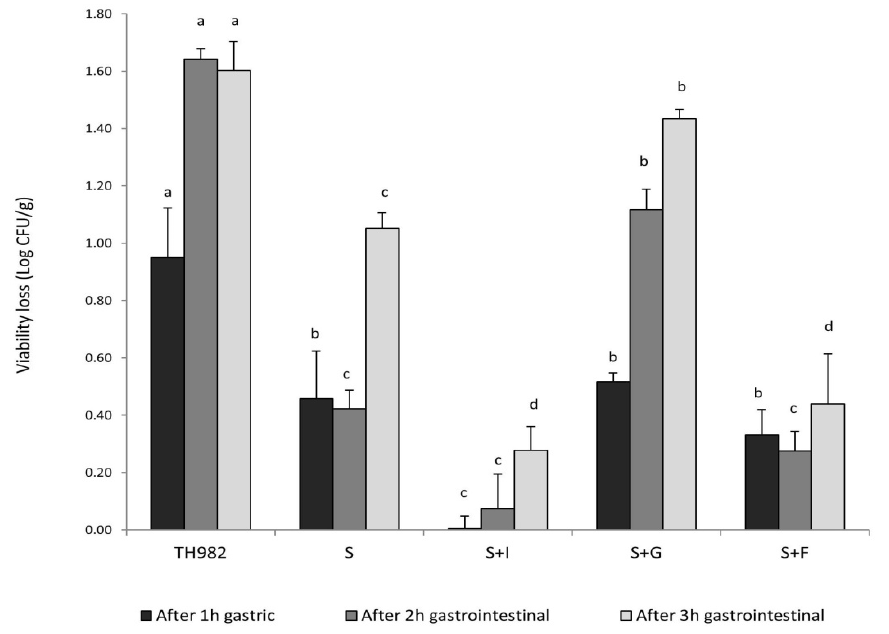
Figure 3. Survivability of encapsulated and free S. thermophilus TH982 cells during exposure to simulated gastrointestinal conditions. Different letters indicate significant differences within the same incubation step ( p < 0.05) among different encapsulating matrix types.